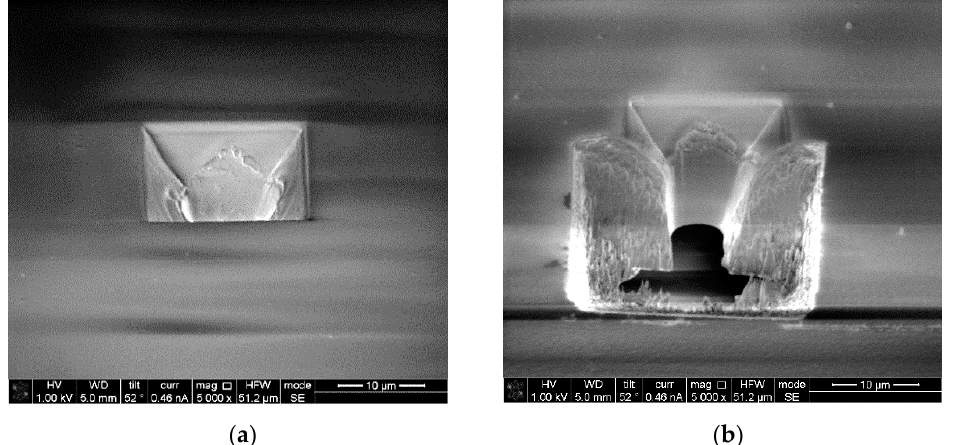
Figure 9. Focused ion beam (FIB) cross-sectional view of a single micropore ( a ) before and ( b ) after FIB-cut sectioning.